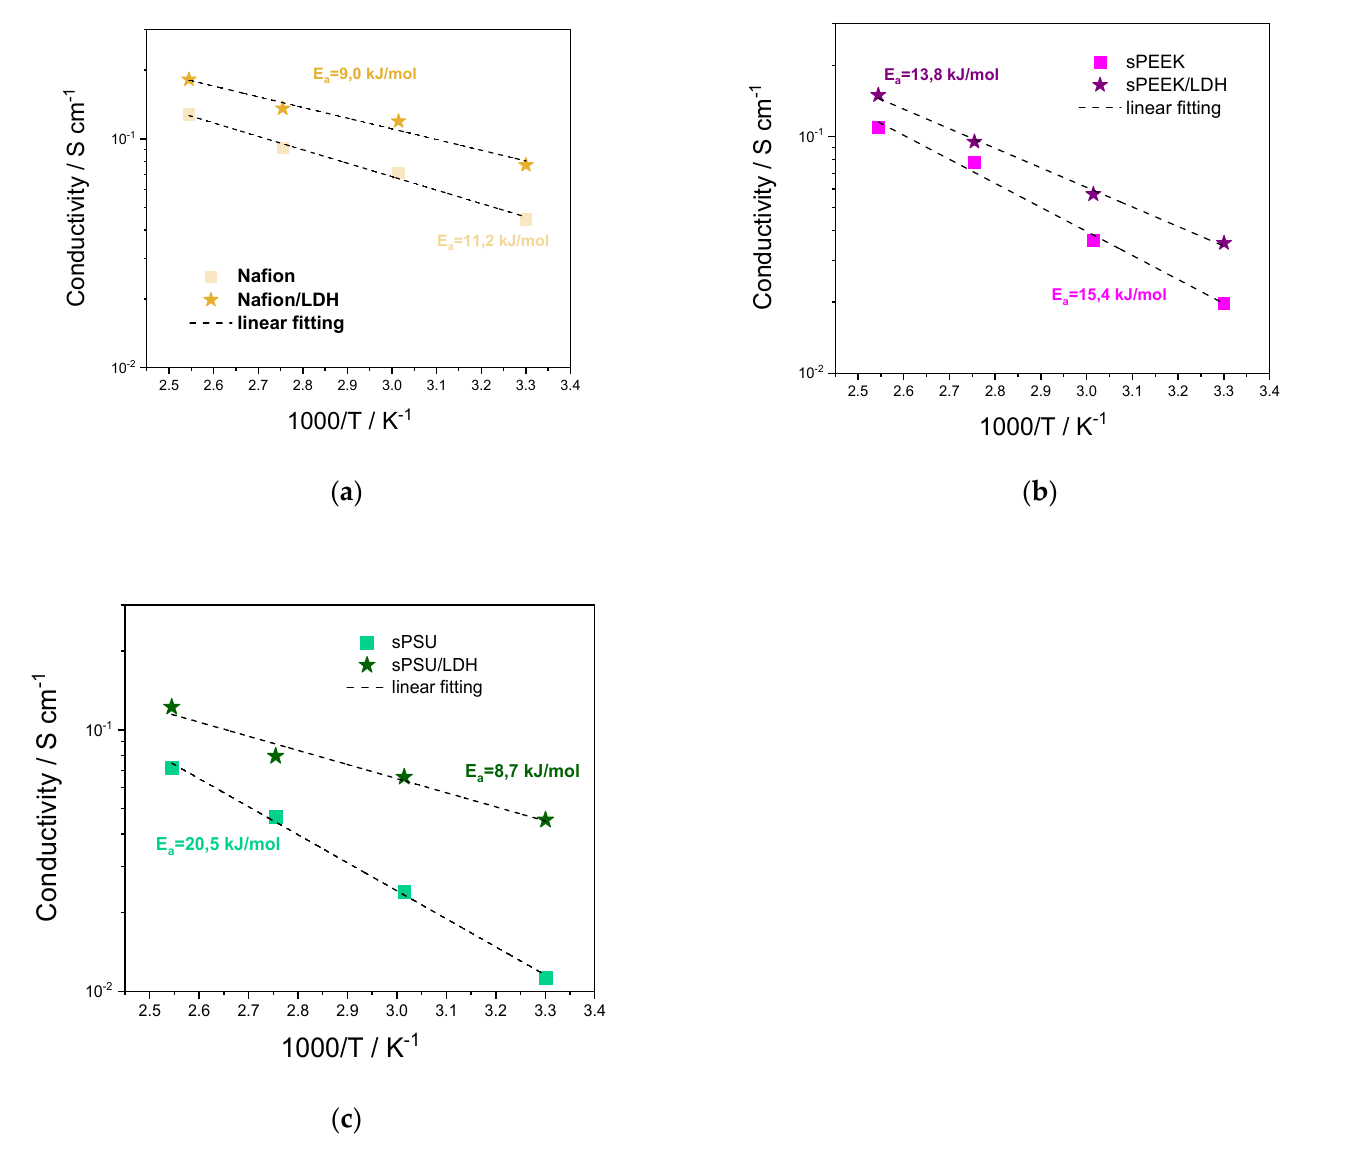
Figure 8. Arrhenius plots of proton conductivities at 90% RH of ( a ) Nafion and Nafion/LDH, ( b ) sPEEK and sPEEK/LDH and ( c ) sPSU and sPSU/LDH. Dash lines represent the linear fitting to experimental data.